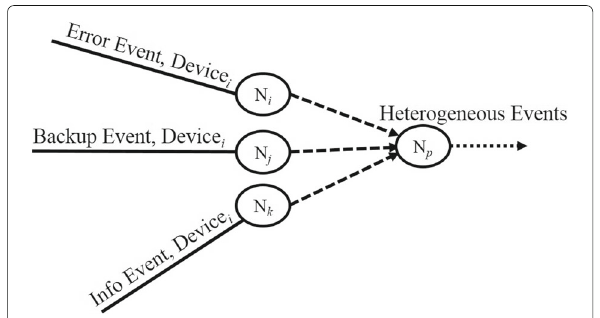
Fig. 5 Heterogeneous Event Stream